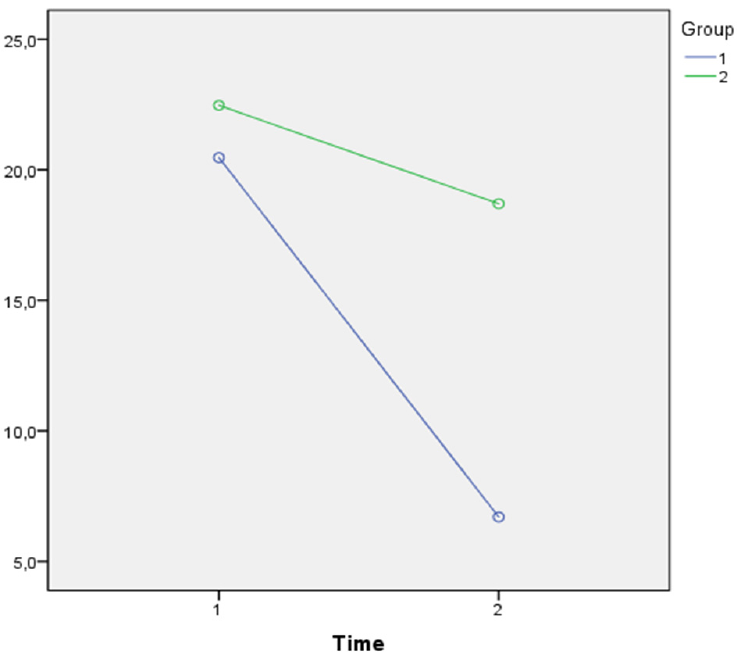
Figure 3. Comparison of the average NPI_aXb in the EG (purple line) and in the CG (green line) over time.